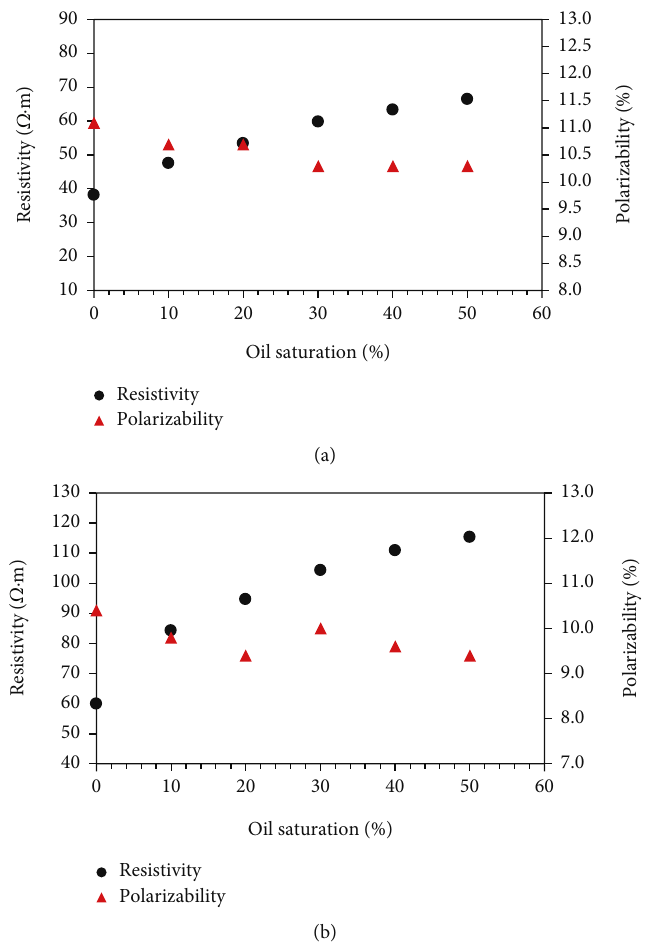
Figure 12: (a, b) The inversion results of the complex resistivity of samples 1 and 5 under di ff erent oil saturation conditions,